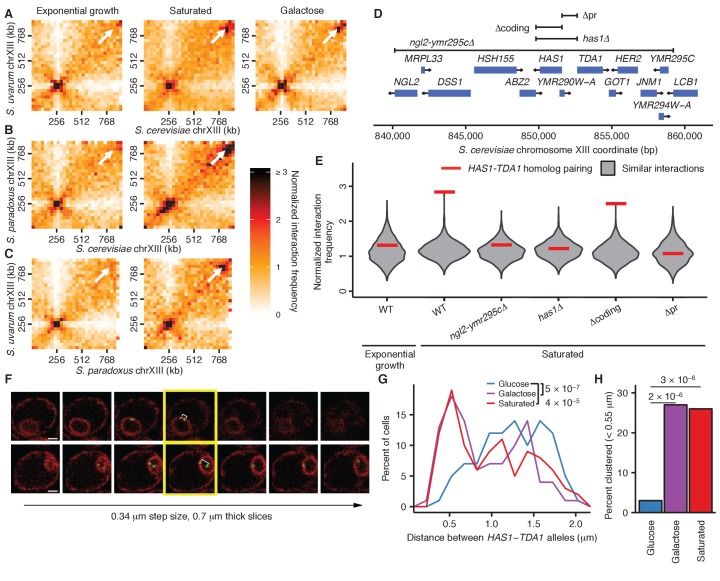
Inducible pairing of HAS1-TDA1 homologs is evolutionarily conserved and sequence-specific.(A), (B), and (C) Hi-C contact maps of chromosome XIII interactions at 32 kb resolution in S. cerevisiae x S. uvarum (A), S. cerevisiae x S. paradoxus (B), and S. paradoxus x S. uvarum (C) hybrids in exponential growth (left column), saturated cultures (middle column), and in S. cerevisiae x S. uvarum hybrids (A), galactose (right column). White arrows indicate the interaction between the homologous HAS1-TDA1 loci. (D) Genome browser shot of open-reading frames (ORFs; blue boxes) and tested deletions (brackets) in the S. cerevisiae region surrounding the genes HAS1 and TDA1, from positions 840,000–860,000 (Figure 4—figure supplement 1A). Arrows indicate ends and directionalities of ORFs. (E) Strength of HAS1-TDA1 homolog pairing at 32 kb resolution (red lines) compared to similar interactions (grey violin plots; i.e. interactions between an S. cerevisiae locus and an S. uvarum locus, where both loci are ≥15 bins from a centromere and ≥1 bin from a telomere, and not both on chromosome XII) in wild-type and deletion strains of S. cerevisiae x S. uvarum. See Figure 4—figure supplement 2 for Hi-C contact maps of deletion strains. (F) Two example z-stacks of images used to measure distances between HAS1-TDA1 alleles tagged with LacO arrays targeted by LacI-GFP (shown in green), with membranes labeled by ER04 mCherry (shown in red). The yellow outline indicates the images chosen for analysis. White brackets indicate the measured distance. Scale bar = 1 µm. (G) Distributions of the distance between the HAS1-TDA1 alleles measured by microscopy in S. cerevisiae diploids in glucose (blue), galactose (purple), and saturated cultures (red). n = 100 for each condition. p-Values were calculated using the Wilcoxon rank sum test. (H) Frequency of HAS1-TDA1 alleles less than 0.55 µm apart, measured as in (G), in glucose (blue), galactose (purple), or saturated cultures (red). p-Values were calculated using Fisher’s exact test.DOI:
http://dx.doi.org/10.7554/eLife.23623.01310.7554/eLife.23623.014Figure 4—source data 1.Raw cell counts for Figure 4G and H.